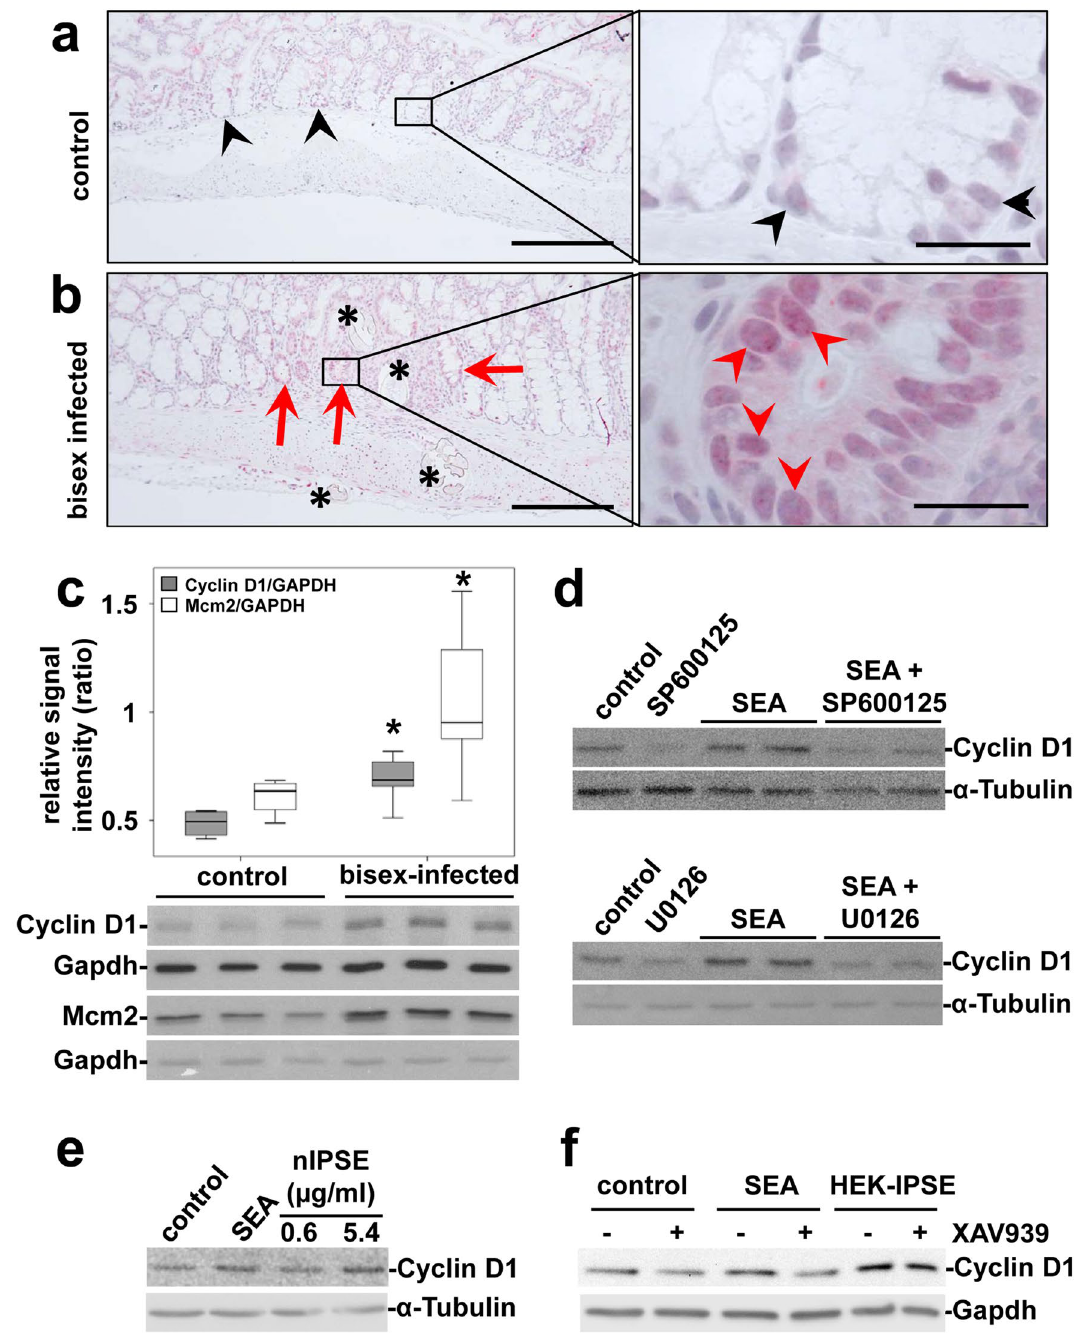
Figure 4. S. mansoni egg-induced expression of proliferation markers. ( a , b ) Increased enterocyte proliferation, denoted by Cyclin D1-immunostaining adjacent [red arrowheads in ( b )] to the eggs (*) was distinct from physiological proliferation of enterocytes in basal crypts [black arrowheads in ( a )]. Representative cross sections of colon mucosa from hamsters are shown.( a ) single sex-infected control, ( b ) bisex-infected. Magnification 200×, bar 2200 µm and 1000×, bar 20 µm. ( c ) Western blot analysis and subsequent semi-quantitative assessment of optical density suggested an enhanced expression of Cyclin D1 and Mcm2 in the colon of S. mansoni bisex-infected hamsters in comparison to single sex-infected controls. Representative blots are shown, control n = 4, bisex infection n = 11. Differences were analyzed statistically between control and bisex-infected for Cyclin D1/Gapdh and Mcm2/Gapdh. * p ≤ 0.05. ( d ) The expression of Cyclin D1 was induced by SEA and could be inhibited by additional treatment with the JNK-inhibitor SP600125 (upper blots) and the MEK- inhibitor U0126 (lower blots) in SW620 cells. The cells were pretreated with inhibitors for 30 min and subsequently during stimulation for 4 h. ( e ) The expression of Cyclin D1 was also induced by nIPSE. ( f ) SEA-stimulated Cyclin D1 expression was reduced by tankyrase inhibition, using XAV939, in SW620 cells. IPSE-induced Cyclin D1 expression, however, was not reduced by tankyrase inhibition. The cells were pretreated with XAV939 for 15 h and subsequently during stimulation for 4 h. The experiment and assay was reproduced at least two times. Representative western blots are